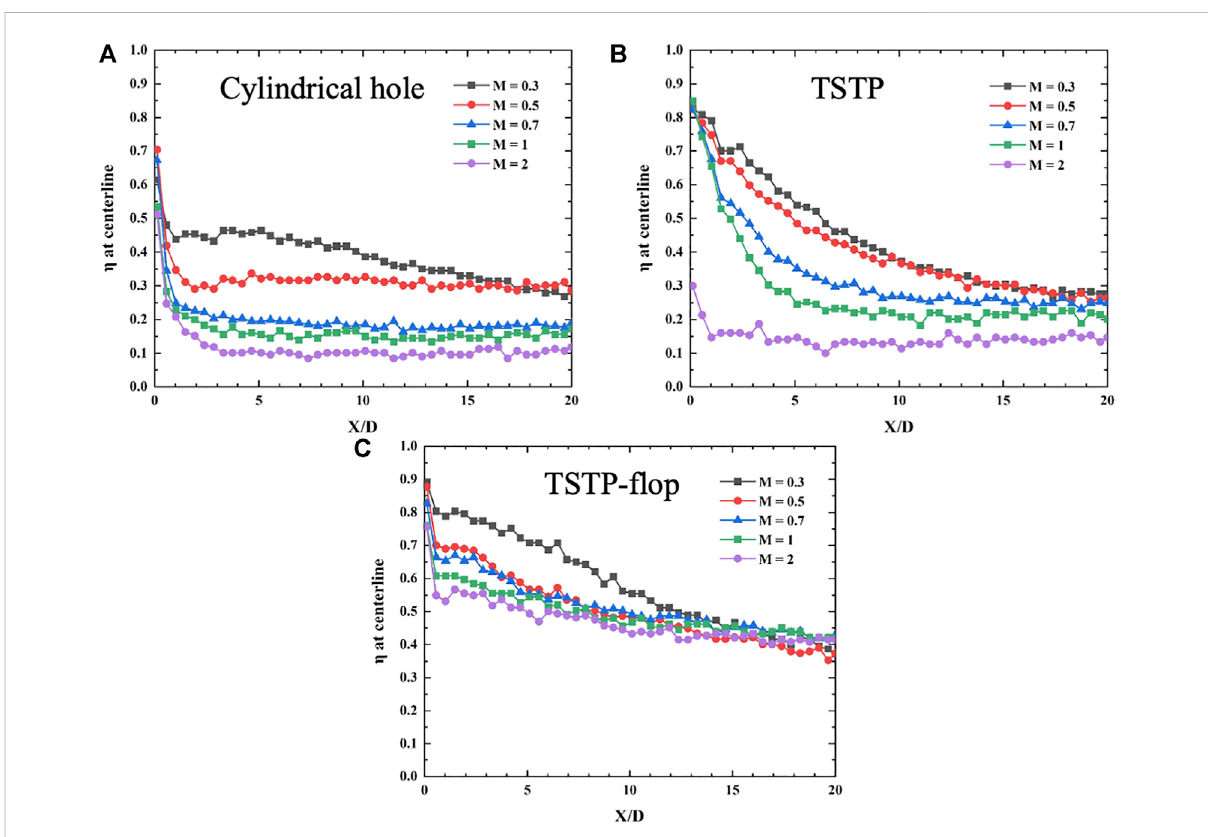
FIGURE 8 Film cooling effectiveness along with the streamline direction for different blow ratios. (A) Cylindrical hole, (B) TSTP, (C) TSTP- fl